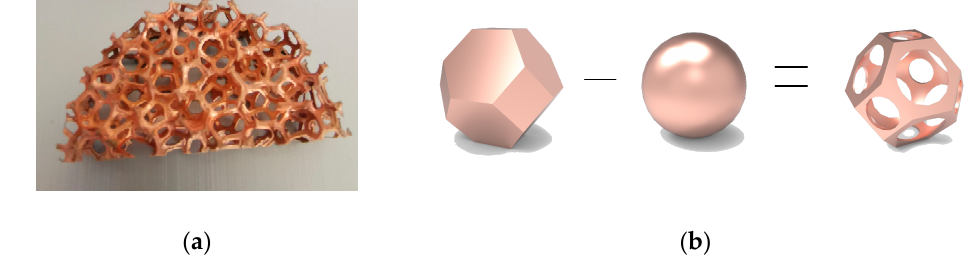
Figure 4. Copper foam. ( a ) Optic image. ( b ) Simplified structure.